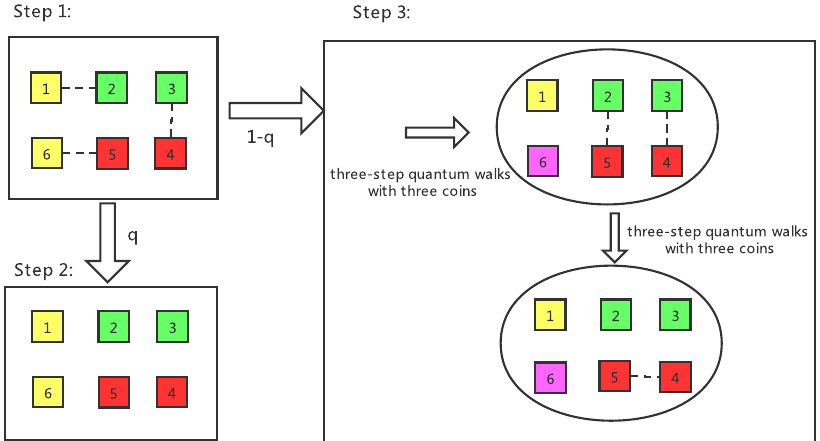
Fig. 5 The schematic diagram of the improved multiparty quantum secret sharing. The small boxes indicate particles and the dotted lines indicate entanglement. The particles in yellow belong to Alice. The particles in green and red are in Bob ’ s and Charlie ’ s possession. The purple particle has been performed by a unitary